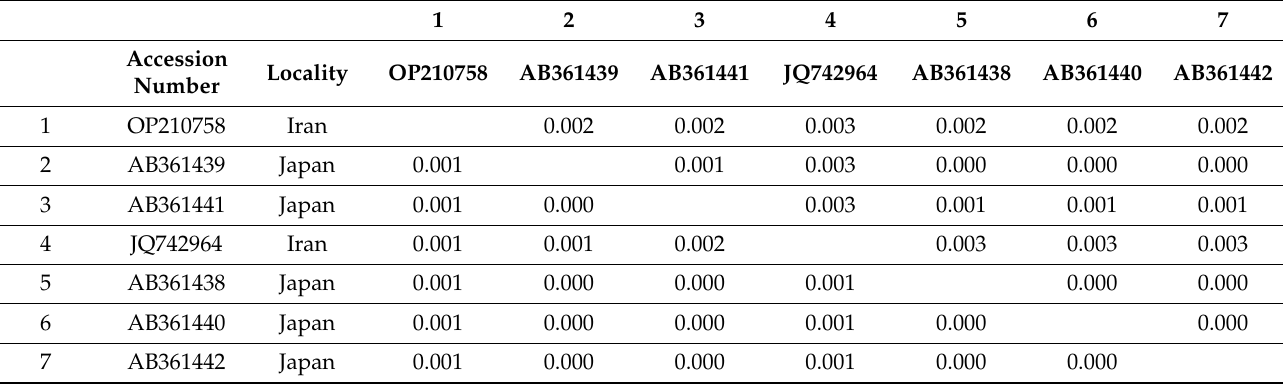
Table 2. Genetic pairwise distance of different populations of Mylonchulus hawaiiensis